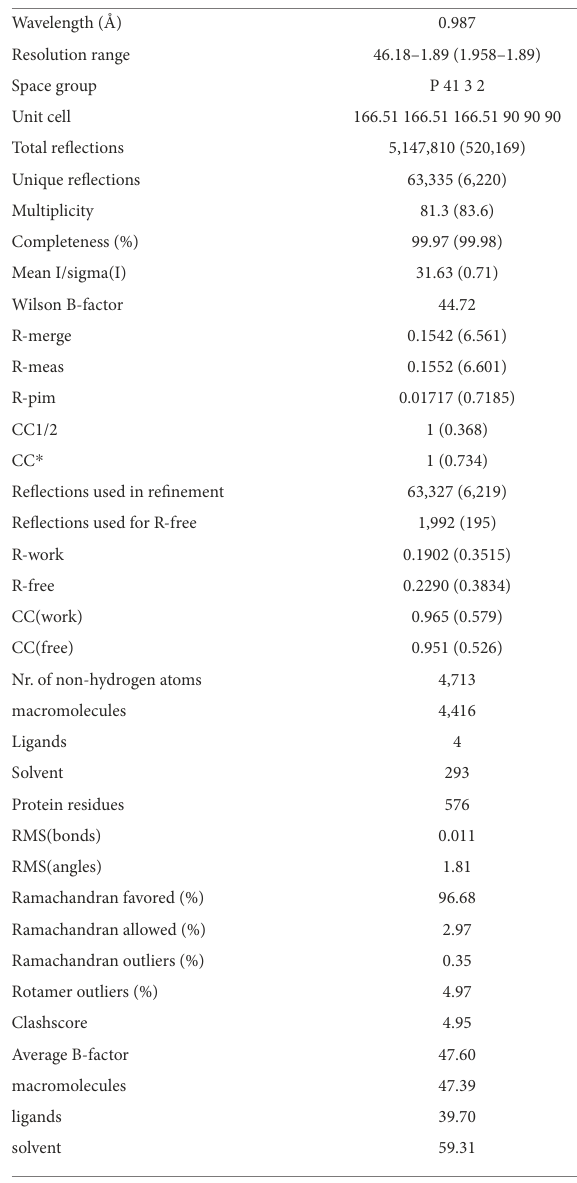
TABLE 2 X-ray diffraction data collection and refinement statistics for